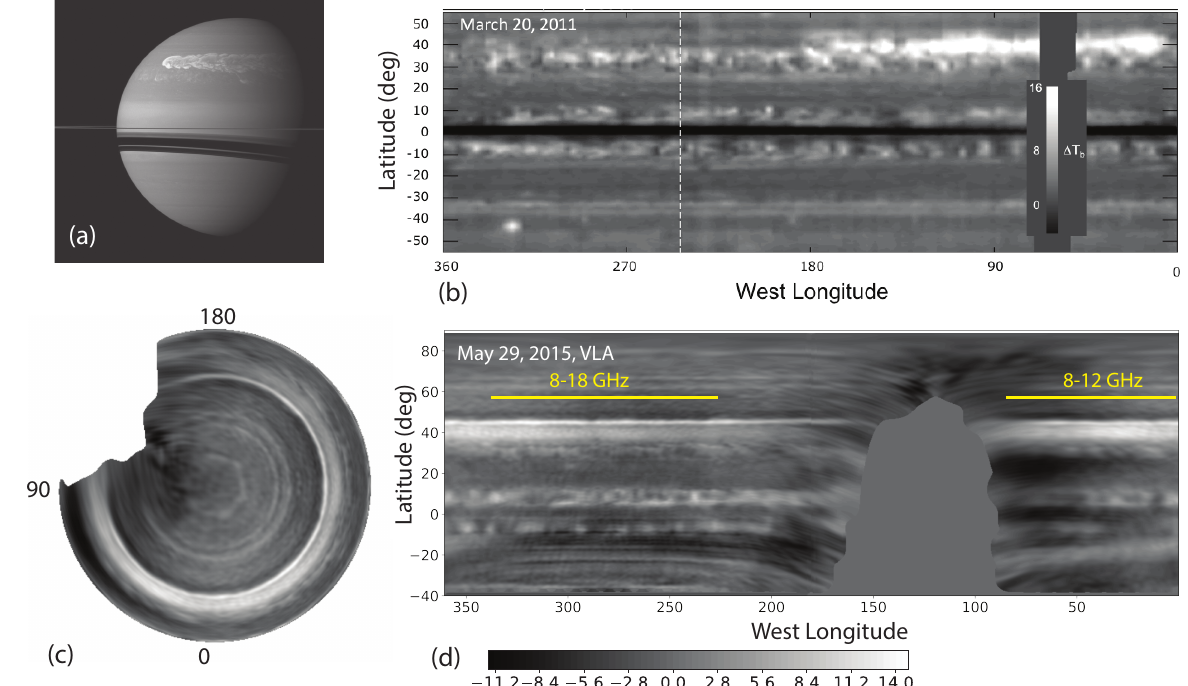
Figure 14. ( a ) Image of Saturn taken by the Cassini spacecraft on 25 February 2011, about 12 weeks after a powerful storm was first detected in Saturn’s northern hemisphere. This storm is seen overtaking itself as it encircles the entire planet. (NASA/JPL/Space Science Institute, PIA12826). ( b ) Cylindrical map of Saturn’s 2-cm brightness temperature constructed from Cassini radiometer observations taken in March 2011. The residual brightness is shown relative to a model for a fully saturated atmosphere. The black stripe across the equator is Saturn’s ring, which blocks the planet’s thermal radiation. The planet was mapped by continuous pole-to-pole scans during 14 h when the spacecraft was near periapse. Periapse (indicated by the dashed line) was at 3.72 Saturn radii, where the spatial resolution was best (1.6 ◦ in latitude) [115]. ( c ) Polar projection of Saturn’s radio map in panel d (i.e., 3- and 2-cm bands combined), revealing the hexagon at its north pole. ( d ) VLA longitude- resolved map from 29 May 2015, after subtraction of a uniform limb-darkened disk and a best-fit model of Saturn’s rings (ring residuals are apparent in the southern hemisphere). Bright features indicate a high brightness temperature. Observations at 3-cm (8–12 GHz) and 2-cm (12–18 GHz) bands are combined; together they cover almost a full rotation of the planet. (panels c , d : Courtesy: R. J. Sault and I. de